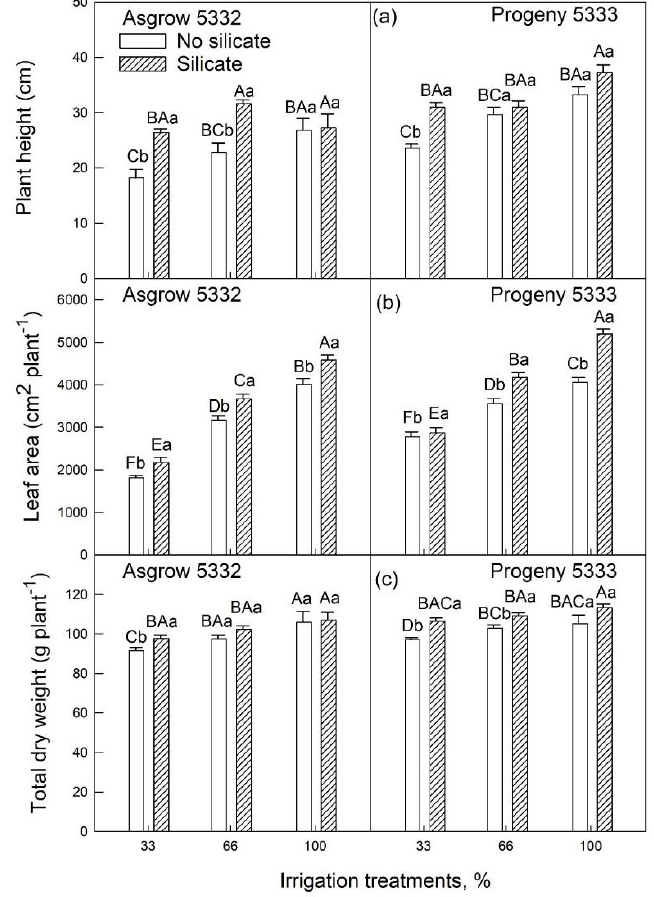
Figure 4. The influence of silicate application on two soybean cultivars ( a ) plant height, ( b ) whole- plant leaf area, and ( c ) total dry weight across three irrigation treatments, measured at 45 days after emergence of the seedling. Three irrigation treatments (33%, 66%, or 100% of required water) were imposed on plants for 20 days. The values are mean and standard errors of five replications in each treatment. The error bars correspond to standard error. The bars followed by the same letters (lower-case letters within silicate and no silicate and upper-case letters within irrigation and silicate treatments) did not differ significantly at 5% by Tukey’s test. Table 2. Analysis of variance across the silicate treatments and their interactions of growth and development, biomass production, and partitioning and physiological traits of soybean plants: plant height (PH), number of nodes (NN) and leaf area (LA), leaf dry weight (LDW), stem dry weight (SDW), root dry weight (RDW), shoot dry weight (SHDW), root/shoot ratio (RS), total dry weight (TDW), root length (RL), root branch number (RBN), and root volume (RV), canopy temperature (CT), net photosynthesis (Pnet), stomatal conductance (Cond), internal CO 2 (C i ), the ratio of internal/external CO 2 concentration, quantum efficiency (Fv’/Fm’), electron transport rate (ETR), transpiration rate (Trans), and water use efficiency